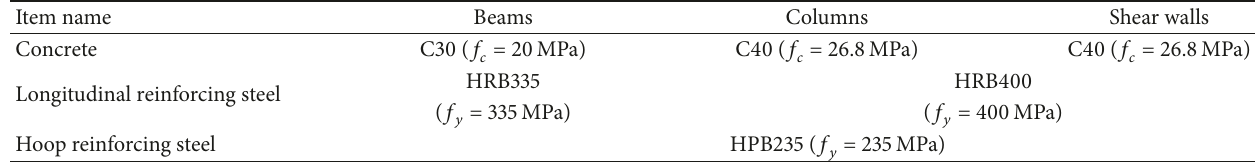
Table 1: Parameters of structural material.